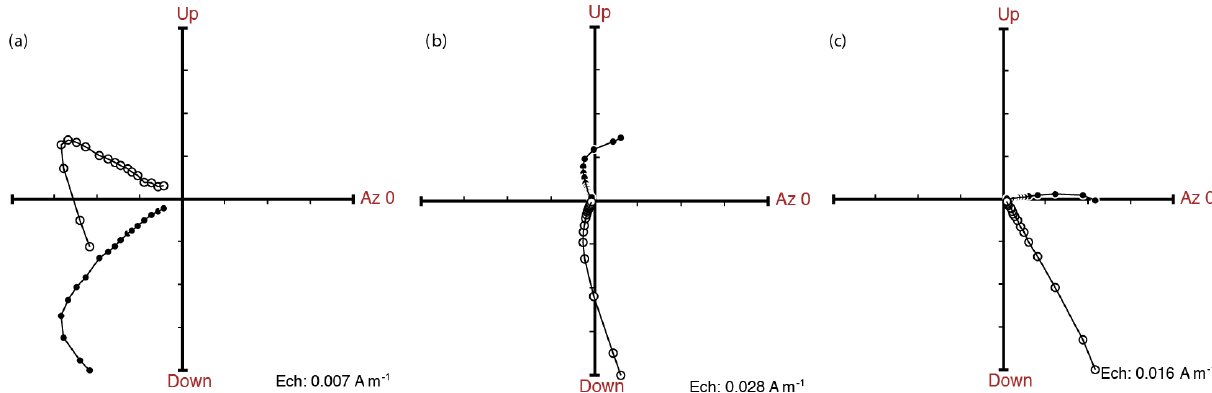
Figure 7. Zijderveld diagram for three samples from les Gours sur Pattes (Leicasse, Site 2, Fig. 1) site. Stratigraphical order is from (a) (the older, base of the profile) to (c) (the younger, top of the profile).